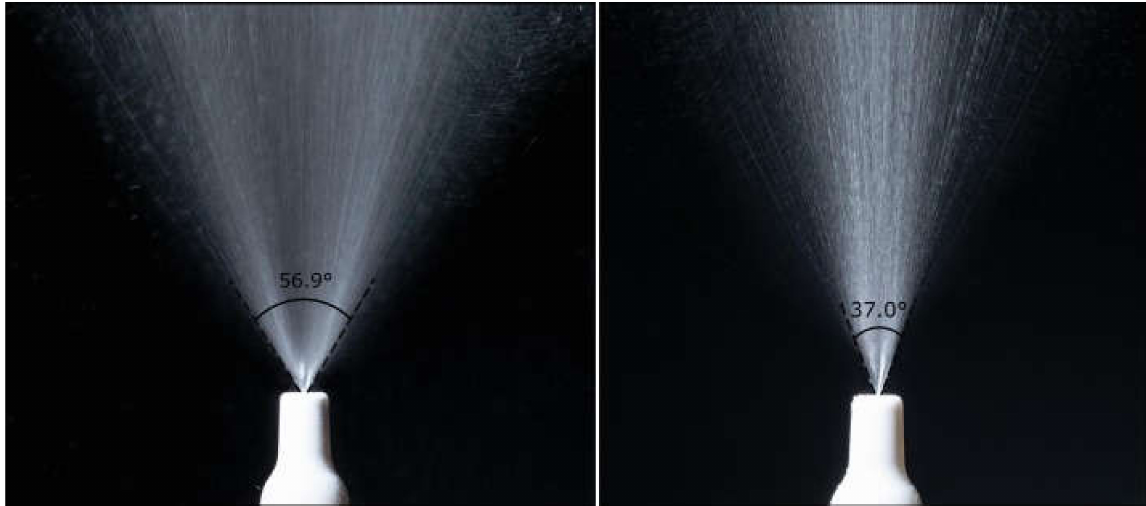
Figure 3. Spray cone angles of in situ gelling fluticasone (0.05%, w/w ) suspensions prepared with ( left ) pectin (0.5%, w/w ) and ( right ) pectin and gellan gum (0.5% and 0.2%, w/w , respectively). Reproduced with permission from [74], Elsevier,